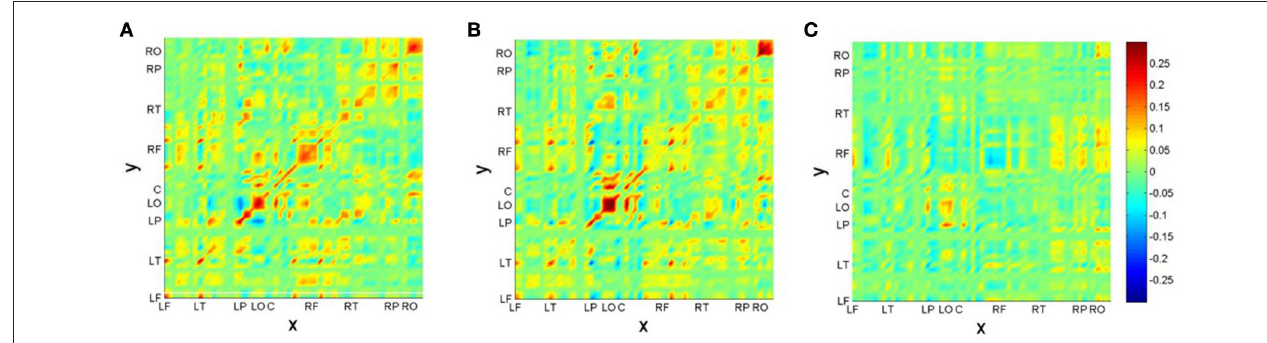
FIGURE 6 | Reconstructed connectivity kernels for the neural field models for conditions (22-a) (A) and (22-b) (B) ; the difference kernel is shown in (C) . Recording channels are given in topographic order: LF, left-frontal; LT, left-temporal; LP, left-parietal; LO, left-occipital; C, central (midline electrodes); RF, right-frontal; RT, right-temporal; RP, right-parietal; RO, right-occipital.